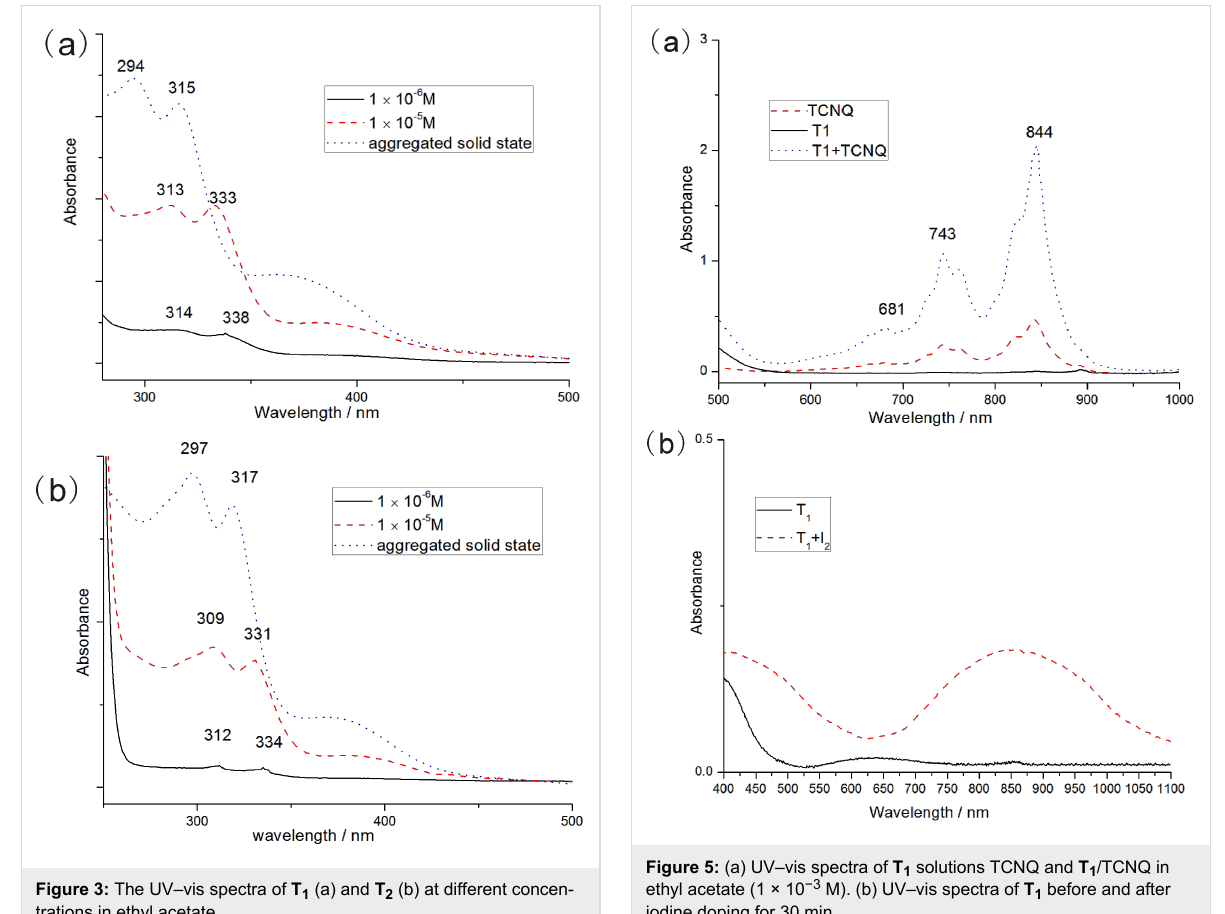
degassed dichloromethane solution [28]. Both T 1 and T 2 displayed two, reversible, one-electron redox couples, in which the first oxidation at = +0.628 V ( T 1 ) and +0.643 V ( T 2 ) (vs Ag/AgCl) was in the anodic window. This indicated the